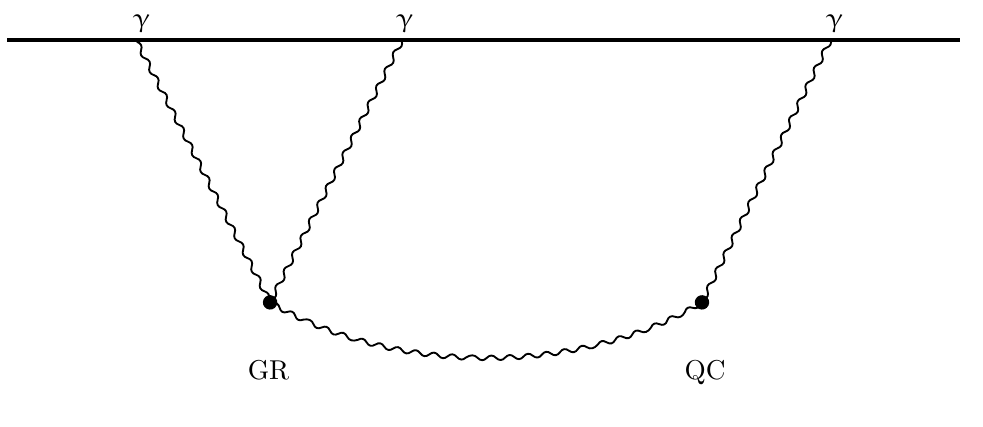
Figure 2 . Single exchange